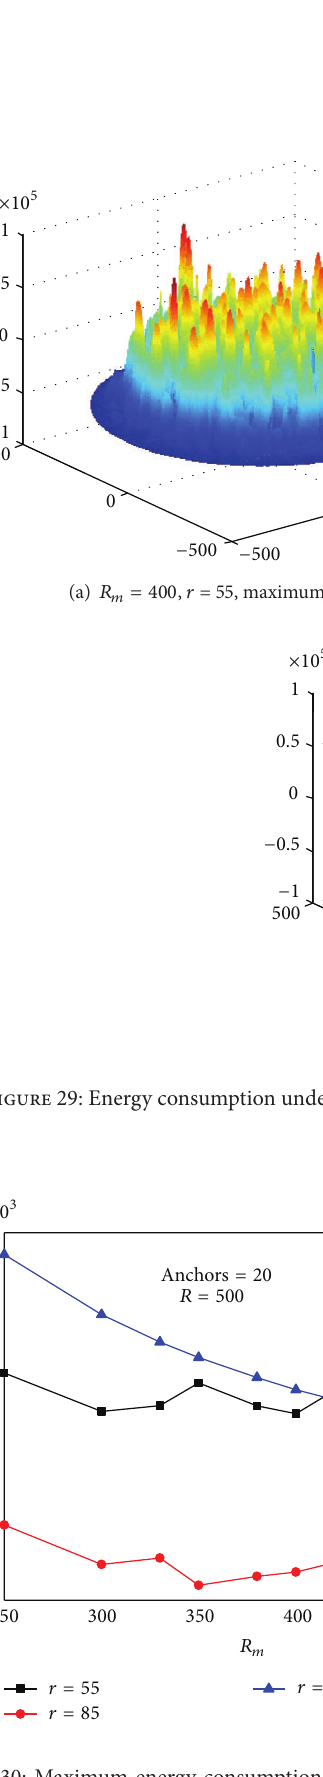
Figure 31: Maximum energy consumption under different trans- mission range and 𝑅 𝑚 (experimental